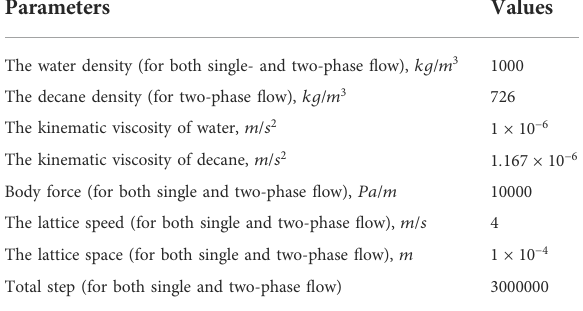
TABLE 1 Fluid properties and LBM simulation parameters.